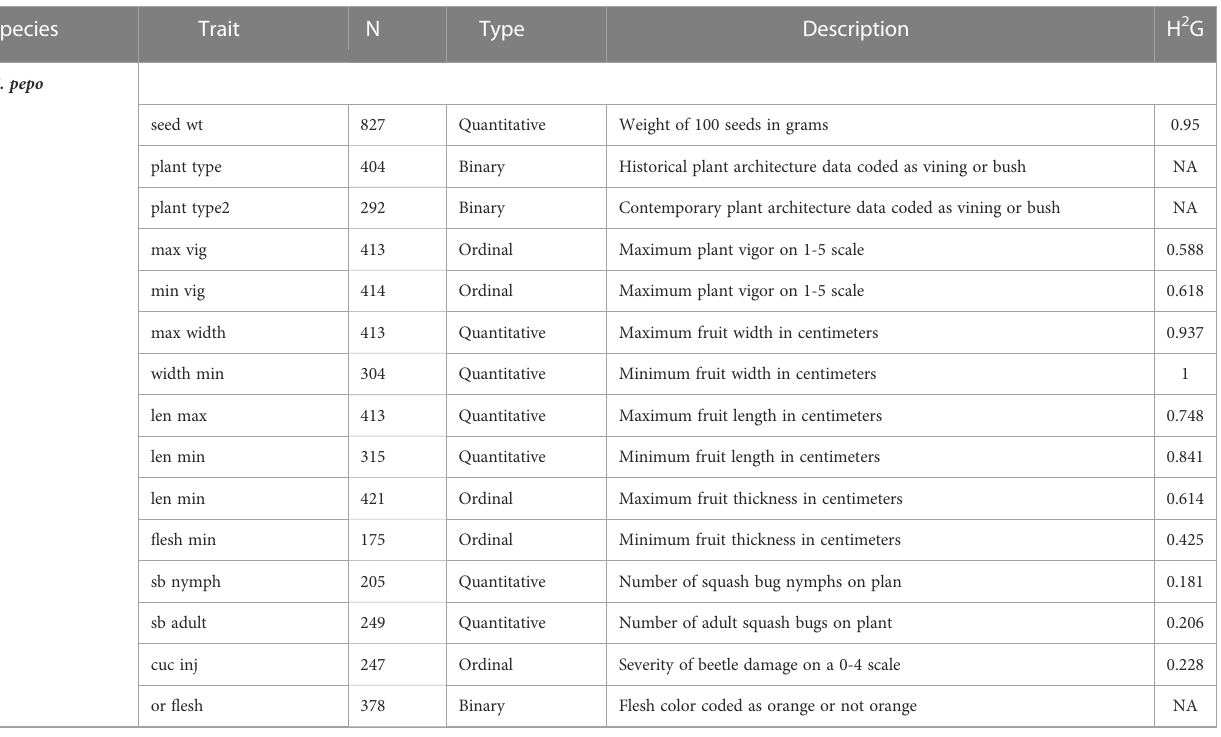
TABLE 3 Descriptive data for each trait including trait type, number of data points for each trait, a brief trait description, and an estimate of genomic heritability h 2 G